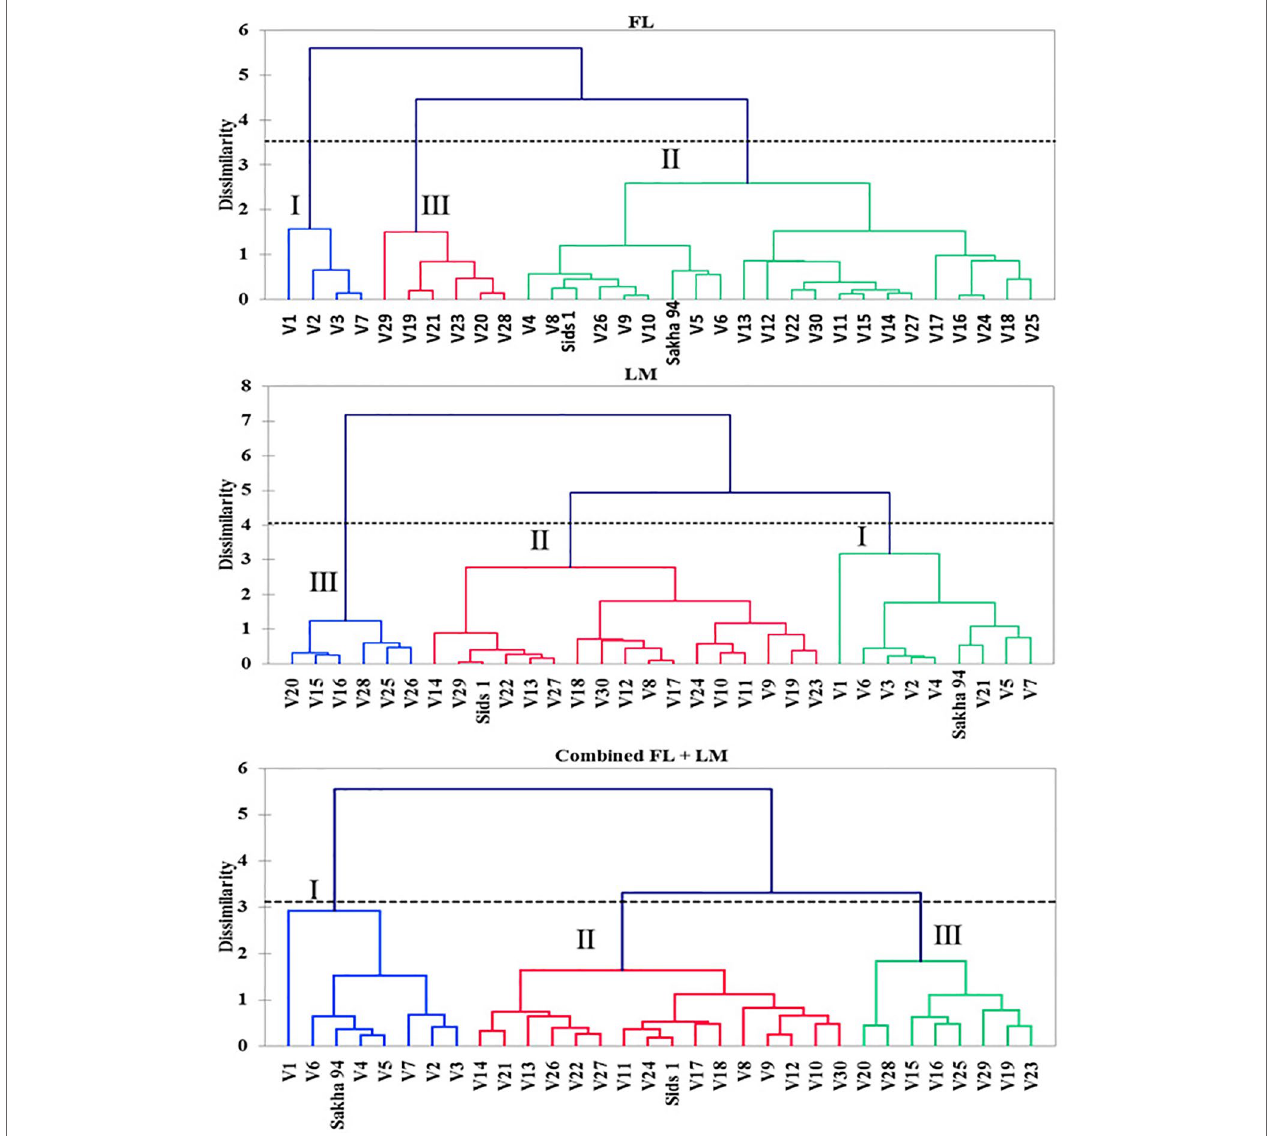
FIgURe 1 | Hierarchical clusters analysis of the 32 genotypes based on measured parameters using Euclidian distance matrix and unweighted pair-group method arithmetic average (UPGMA) under full irrigation (FL), limited irrigation (LM), and the combined two treatments (combined FL+LM).